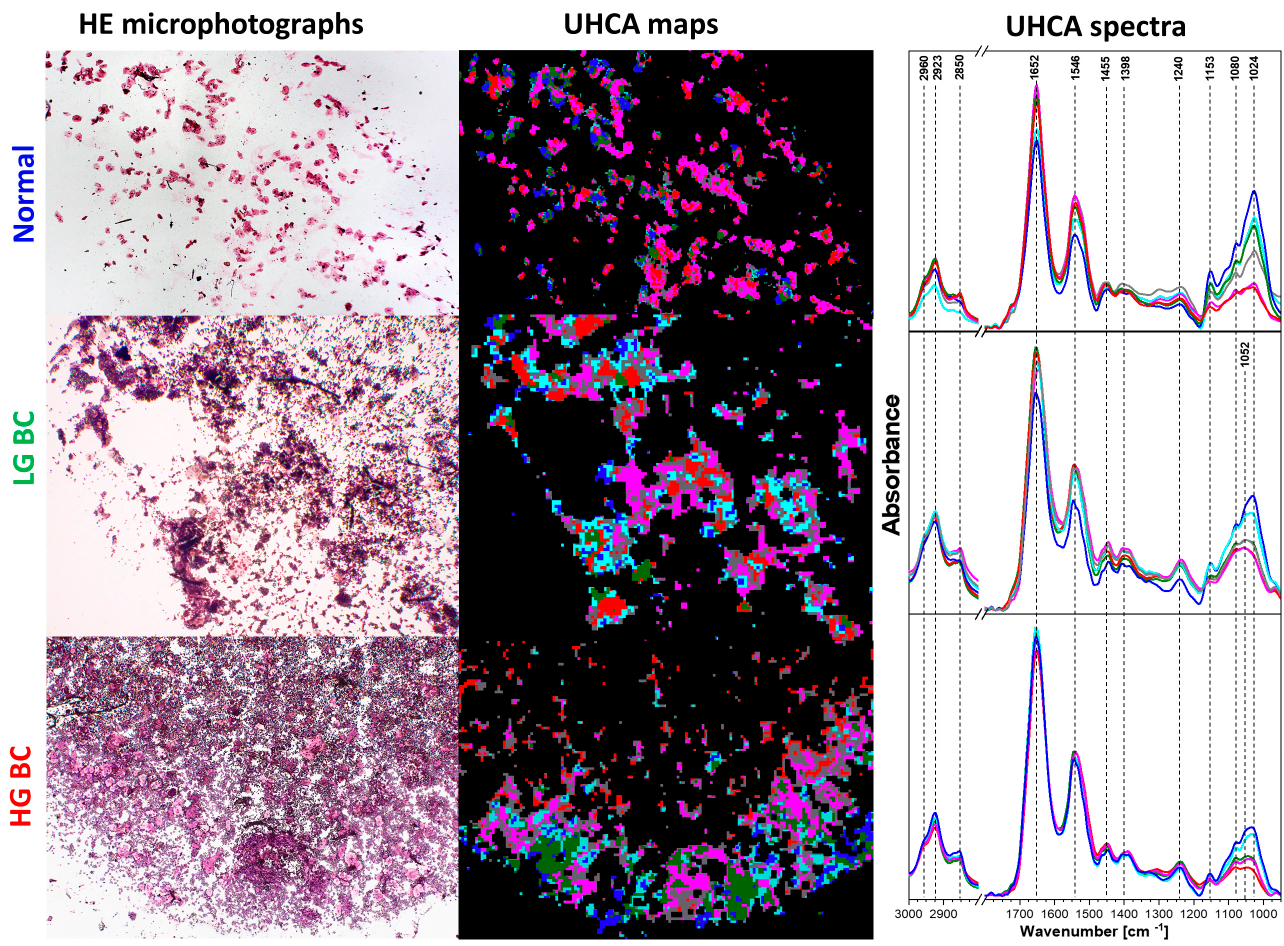
Figure 1. Comparison of the HE microphotographs of normal, LG BC and HG BC cytology (magnification: 100× for normal and LG BC samples and 50× for HG BC) with false-color UHCA maps from IR images and their mean absorbance spectra. The colors of the spectra correspond to the colors of UHCA classes.